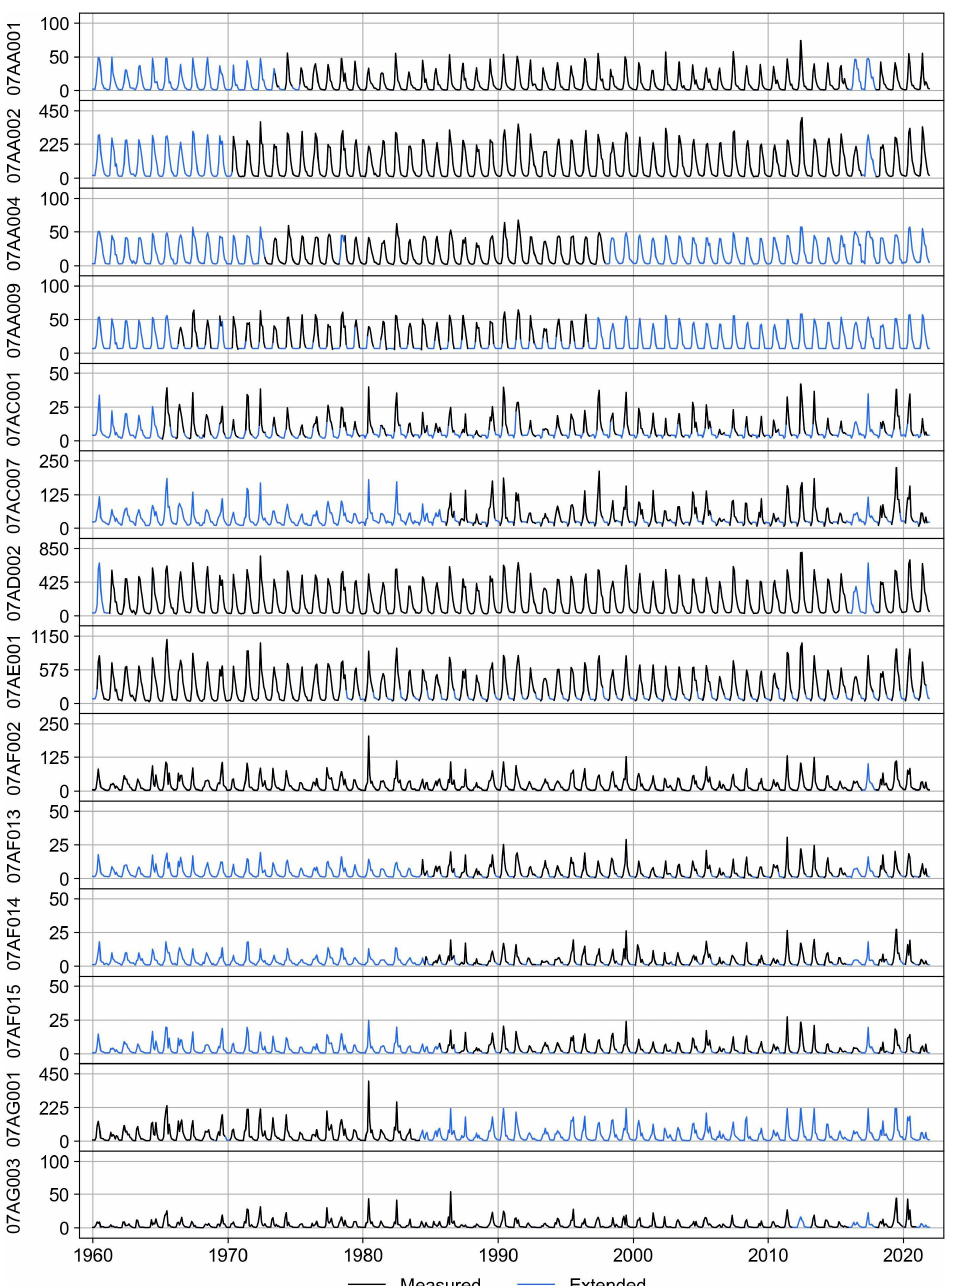
Figure 3. The measured (solid black line) and extended (solid blue line) monthly streamflow (m 3 /s) time series through various regression (solid blue line) modeling Part 1.